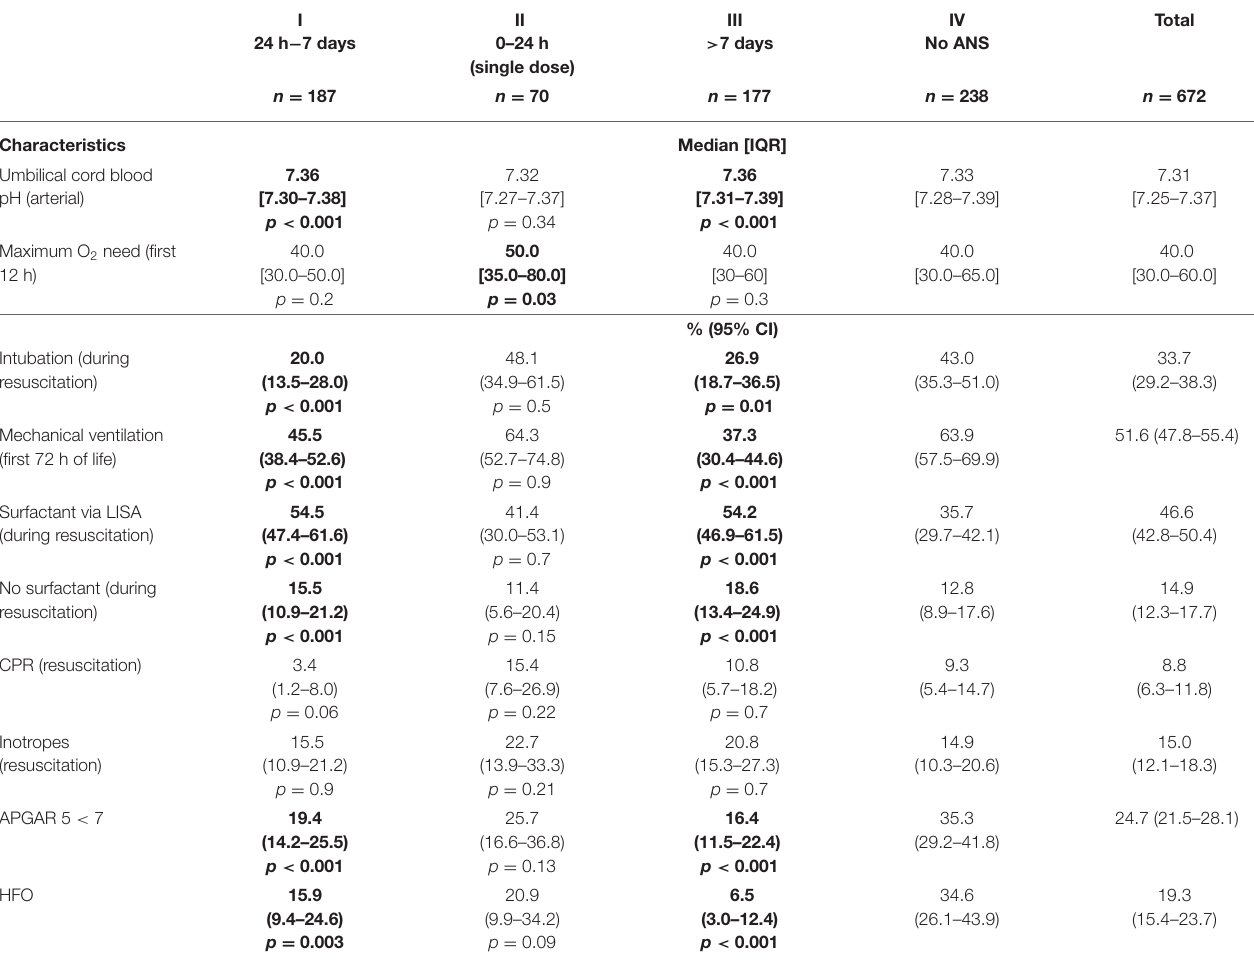
TABLE 3 | Neonatal treatment characteristics stratified by ANS timing